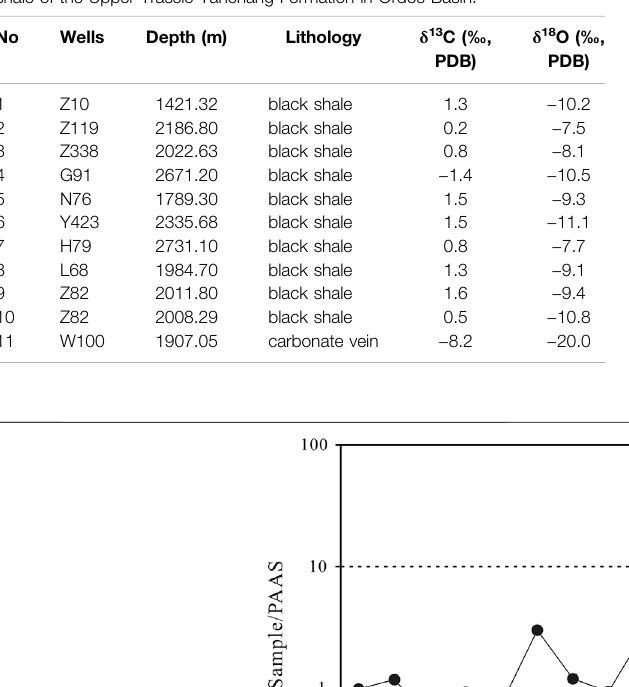
TABLE 2 | Carbon and oxygen isotopes of carbonate from the Chang 7 black shale of the Upper Trassic Yanchang Formation in Ordos Basin.